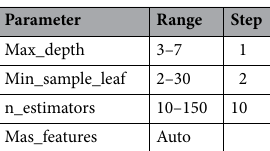
Table 8. Hyperparameters of the random forest grid